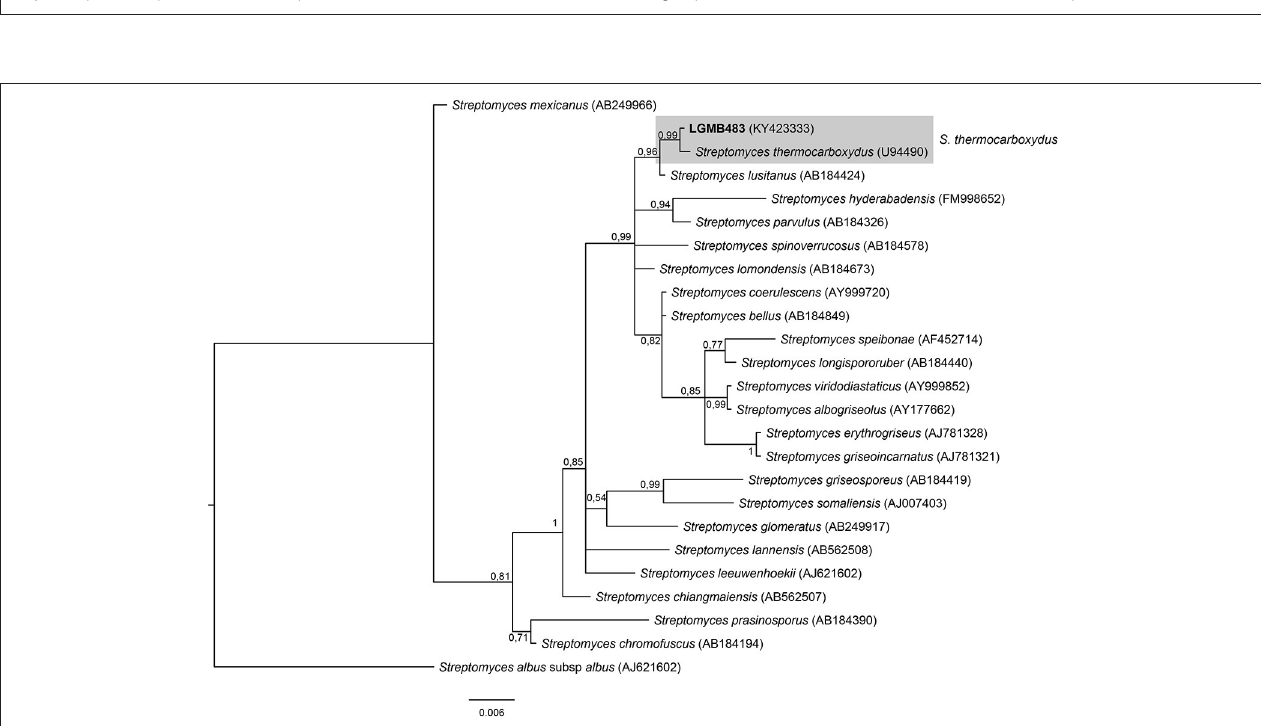
FIGURE 7 | Bayesian phylogenic tree based on 16S rRNA gene of LGMB483 and the 33 type strain of Streptomyces genus. Values on the node indicate Bayesian posterior probabilities. The species Streptomyces albus subsp. albus was used as out group. Scale bar indicates the number of substitutions per site.